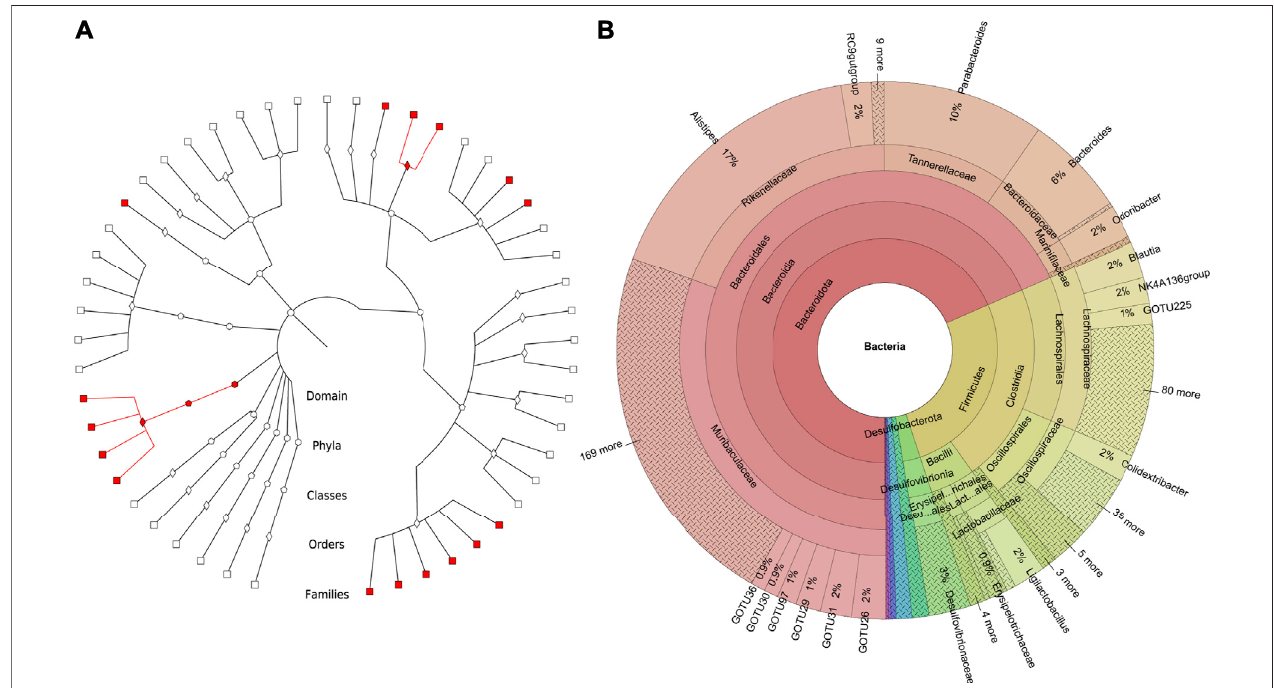
FIGURE5| PlotsproducedfromtheTIC-PipelinefromthemousedatasetofMulleretal. (A) Graphlanplotdepictingthetaxonomictreeofthedenoisedsequences after TIC incorporated both novel (red) and known (white) clades up to the family level. (A) Krona plot quanti fi es the size of each taxonomy in the merged study samples. Contains novel and known taxonomies as produced by the SINA classi fi er and